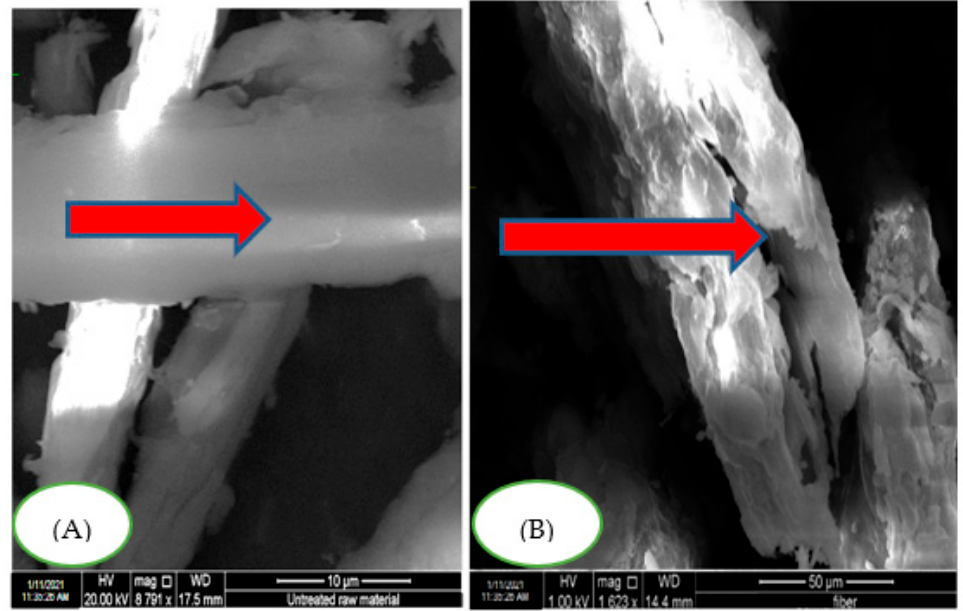
Figure 3. Image of raw M. azedarach wood ( A ) and produced pulp ( B ).